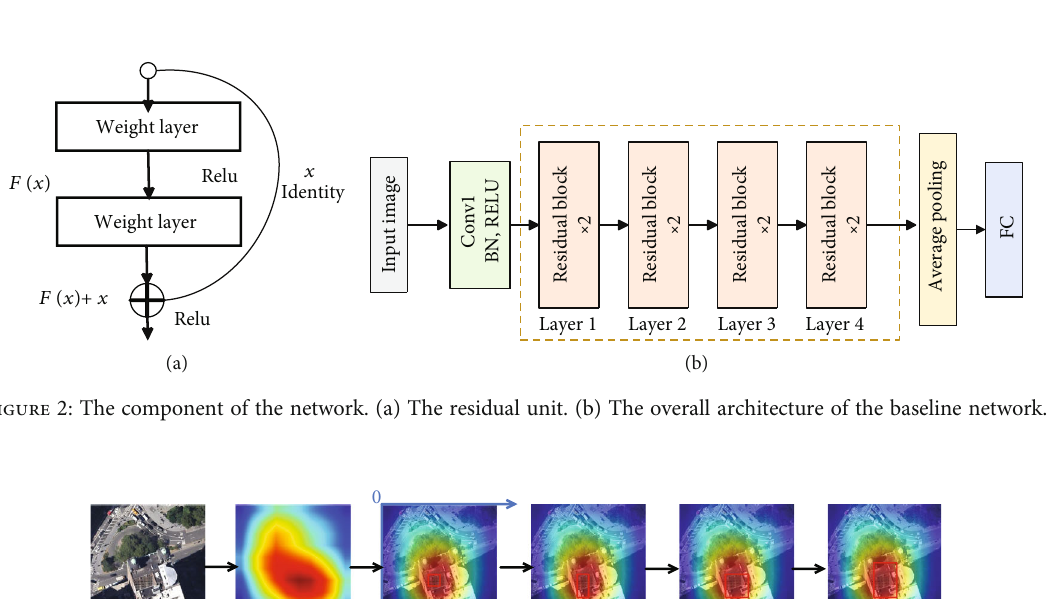
Figure 1: Overall framework of the proposed method. The green branch above extracts the global features, and the gray branch below extracts the local features. The middle part can locate the local key regions and link the two branches.